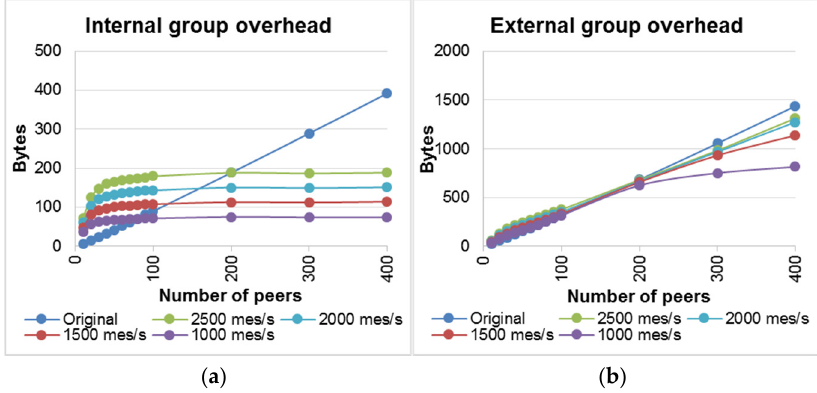
Figure 9. Internal ( a ) and external ( b ) group overheads in bytes for a system with delays from 50 to 550 milliseconds.